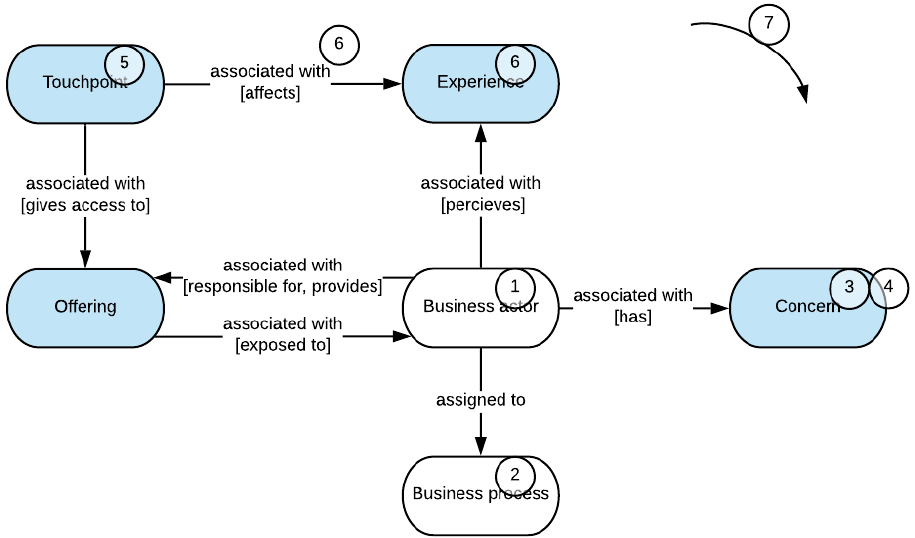
Figure 13. Procedures for modeling of customer